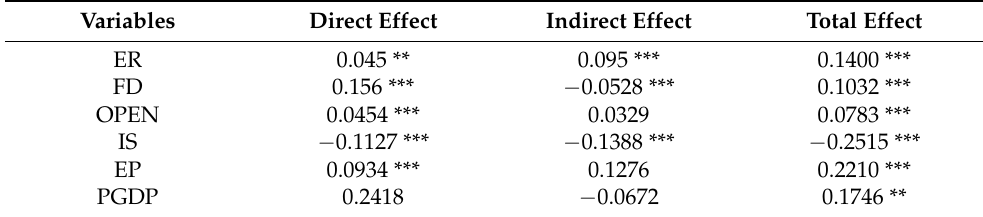
Table 8. Decomposition results of spatial spillover